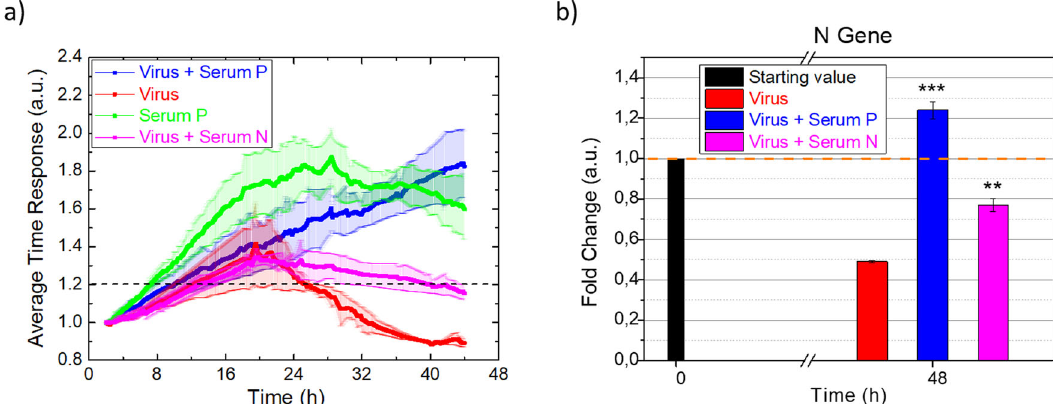
Fig. 3 Reproducibility of OECTs for viral infection evaluation. a Average OECT normalized time response over three different devices with standard deviation (semi-transparent shadow) monitoring viral-infected cell lines (red), with neutralizing (blu) and non-neutralizing (magenta) antibodies, and Serum P on cells as a control (light green). b Graph reporting the average normalized values of qRT-PCR Allplex Seegene analysis of the selected device cultures at the beginning and at the end of the experiments. ** p < 0.01 and *** p < 0.001 denote signi fi cant differences with respect to the “ Virus ” data (red